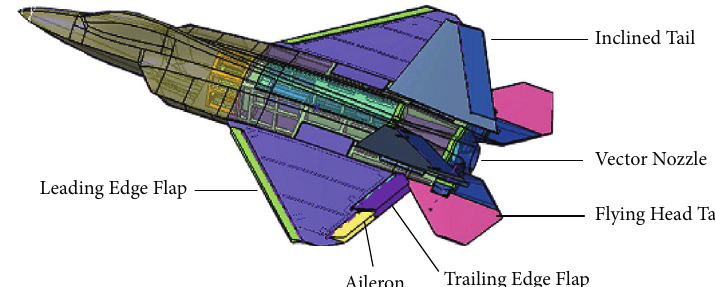
Figure 1: Scale model of the advanced fi ghter.